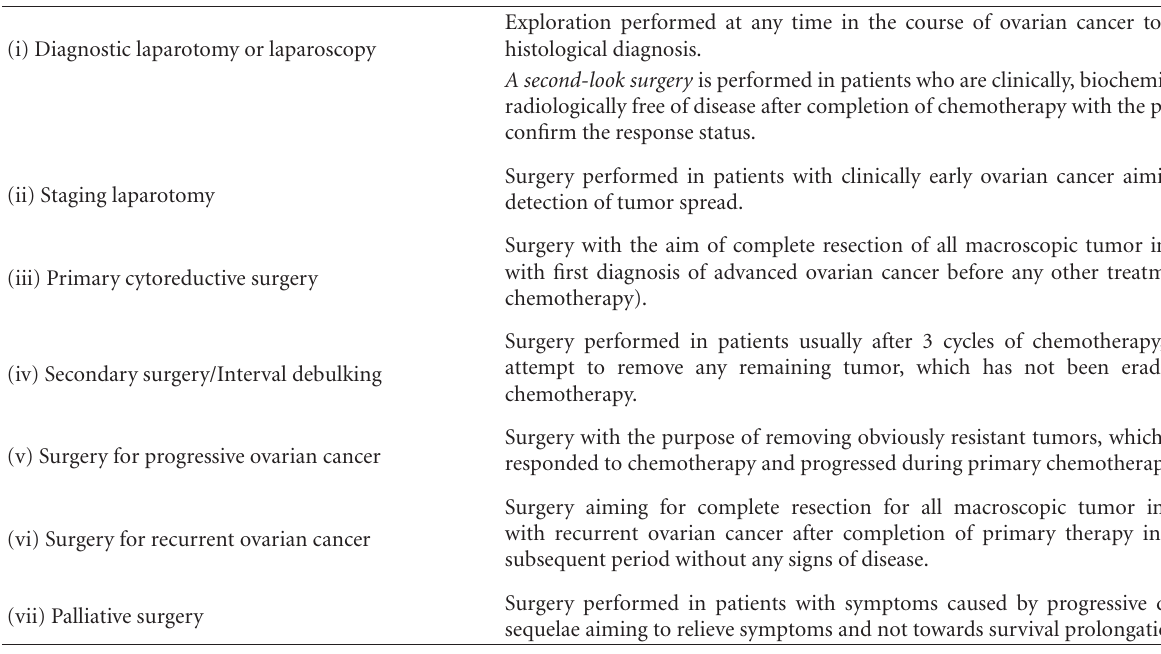
Table 1: Indications for surgery in ovarian